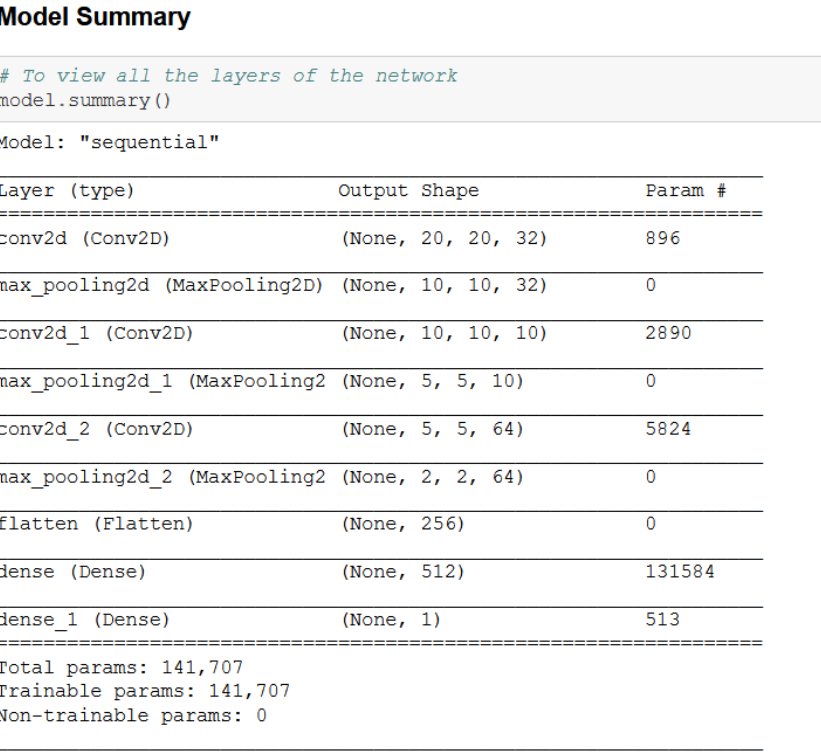
( B ) Figure 4. Image classifications for deep learning model (( A ) shaded vs. ( B ) unshaded). In Stage three, the proposed CNN model was trained to predict shaded and un- shaded houses. Figure 4A shows a shaded house where too many trees cover the sur- rounding of the house, reducing the amount of solar energy collected from PV installation.